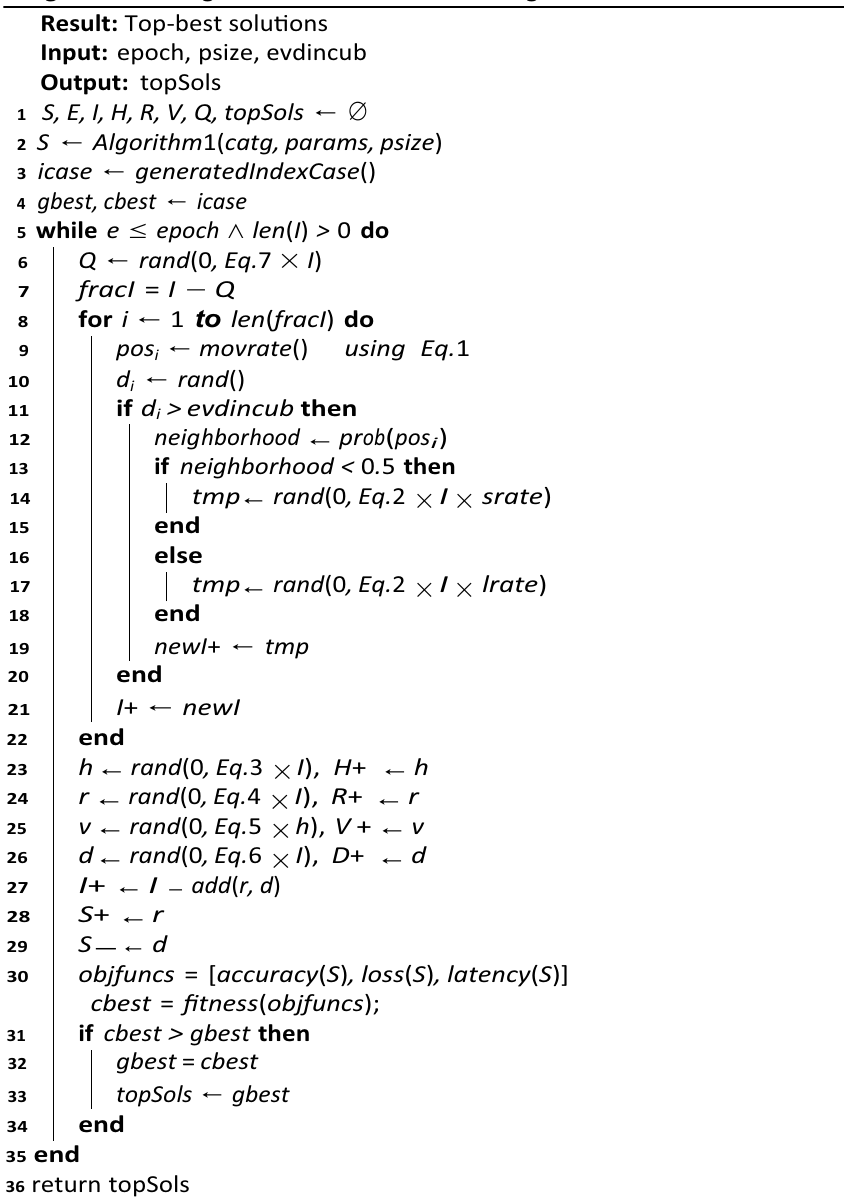
Algorithm 2: Algorithm of the EOSA-NAS